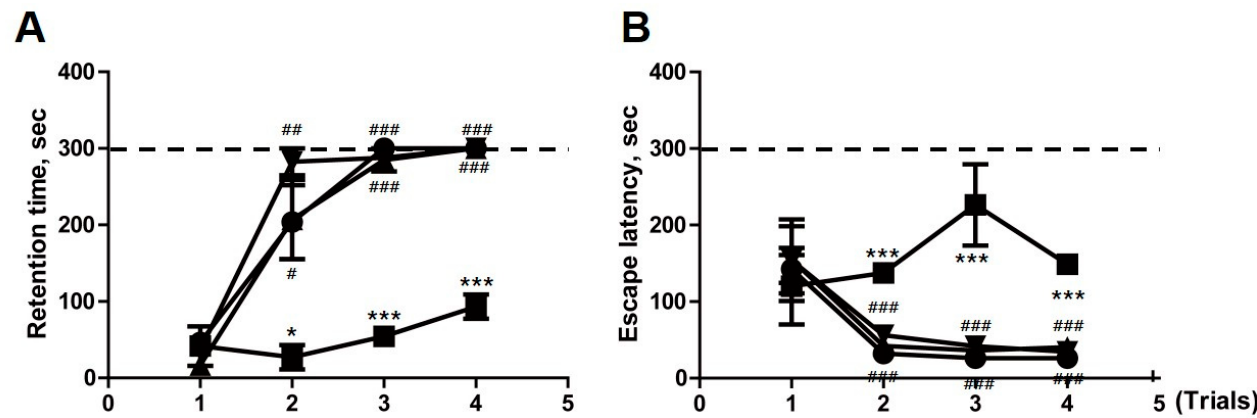
Figure 6. Cognitive function of ovariectomized rats transplanted with F3 or F3.ChAT cells. Cogni- tive function was analyzed through passive avoidance performance ( A ) and Morri water-maze per- formance ( B ). The endopind was set to 300 s, if the animals stayed in light chamber in passive avoid- ance or failed to find the platform in Morris water-maze performance. ● ; normal group, ■ ; Ovariec- tomy (OVx) group, ▲ ; OVx + F3 cells group, ▼ ; OVx + F3.ChAT cells group. * Significantly different from the normal control ( p < 0.05). *** Significantly different from the normal control ( p < 0.001). # Significantly different from the OVx ( p < 0.05) group. ## Significantly different from the OVx ( p < 0.05) group. ### Significantly different from the OVx ( p < 0.05) group.